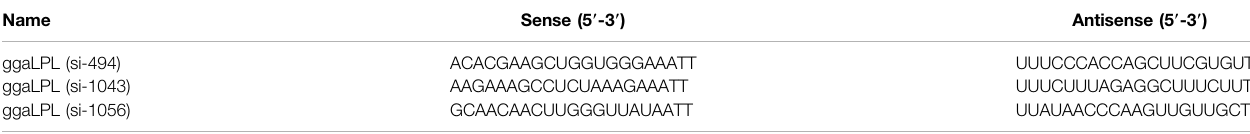
TABLE 1 | Oligonucleotide sequences of small RNA interference